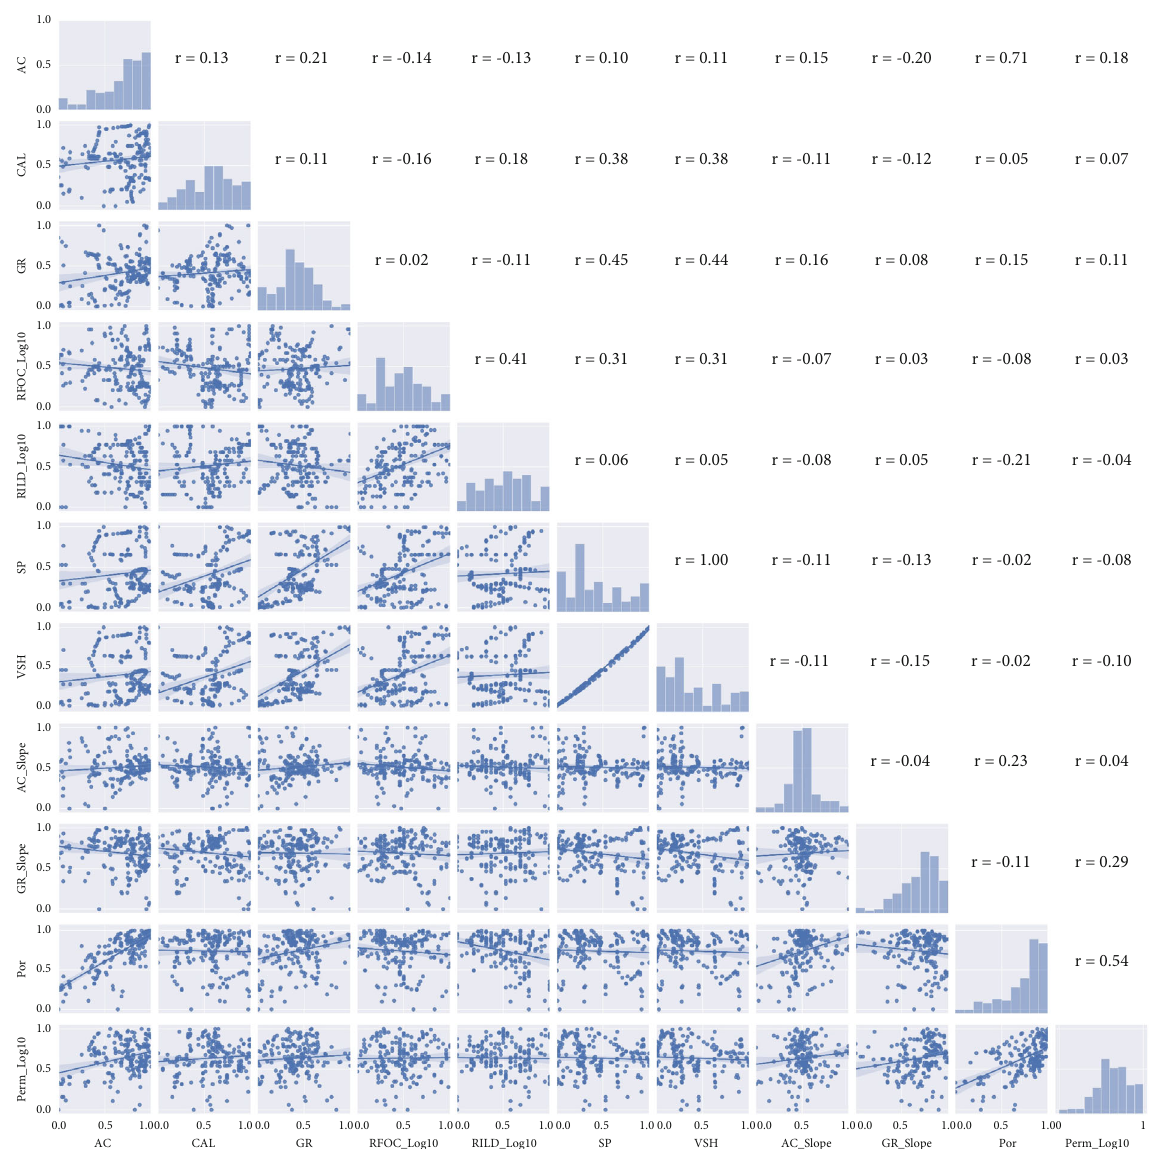
Figure 3: Graphical view of the normalized dataset (r represents the Spearman correlation coe ffi